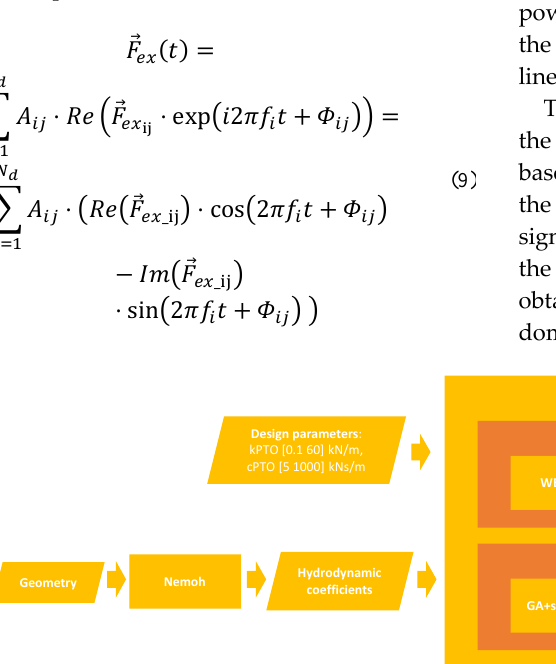
WEC-Sim Power produced Algorithm GA+surrogate fminsearch